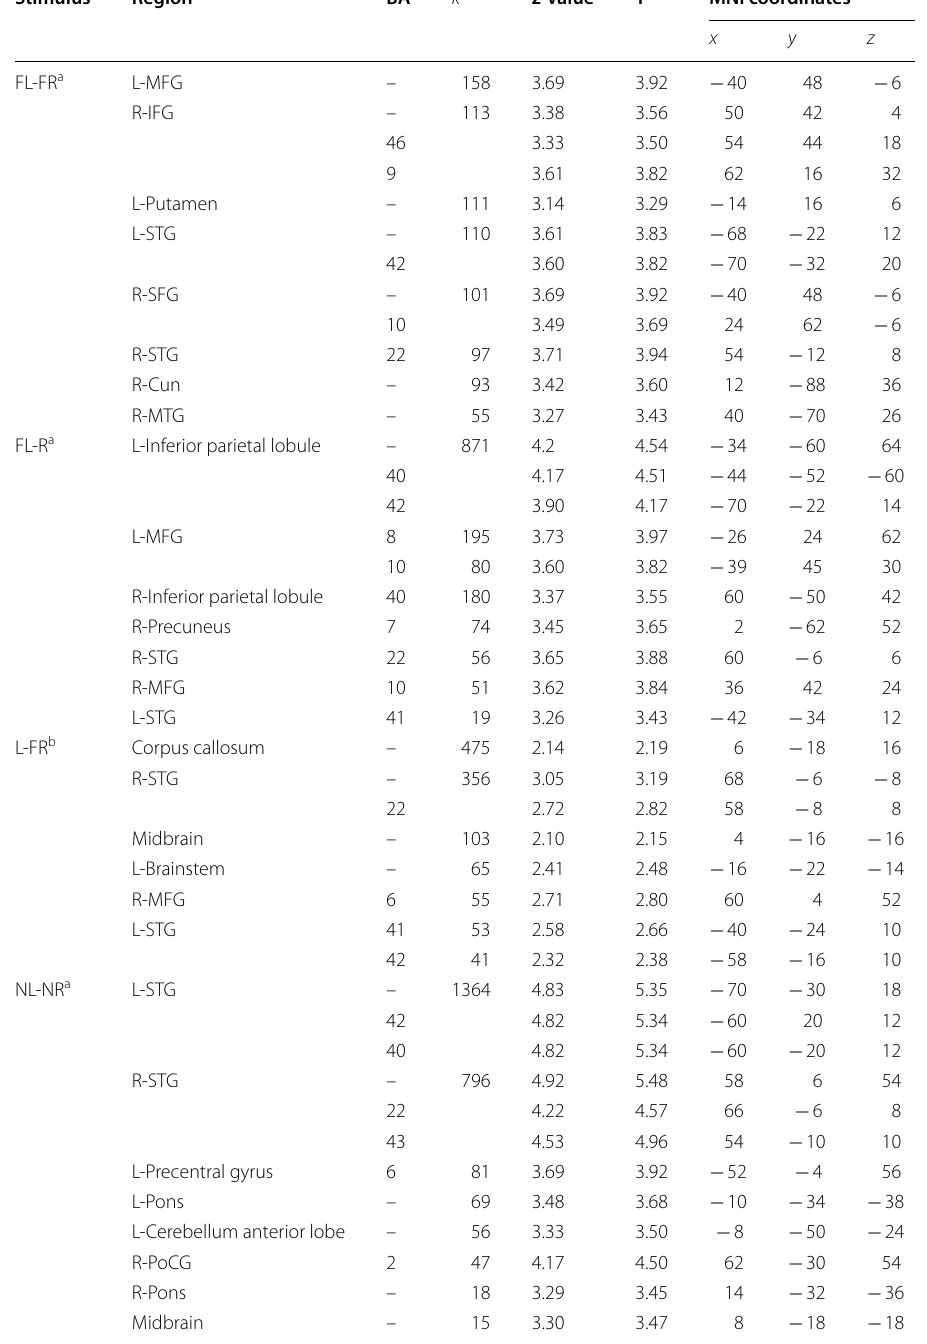
Table 3 Brain activations for FL-FR, FL-R, L-FR, and NL-NR